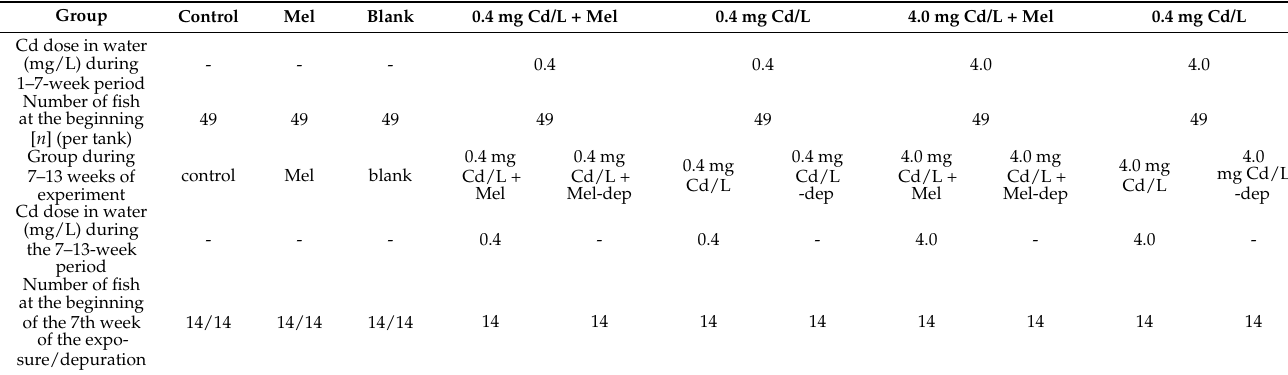
Table 1. The configuration of treatment groups and cadmium doses in water during the 13-week exposure period and the following 6-week exposure or depuration